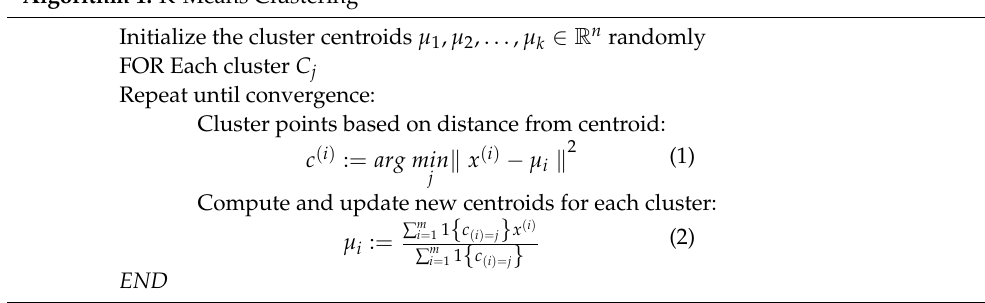
Algorithm 1: K-Means